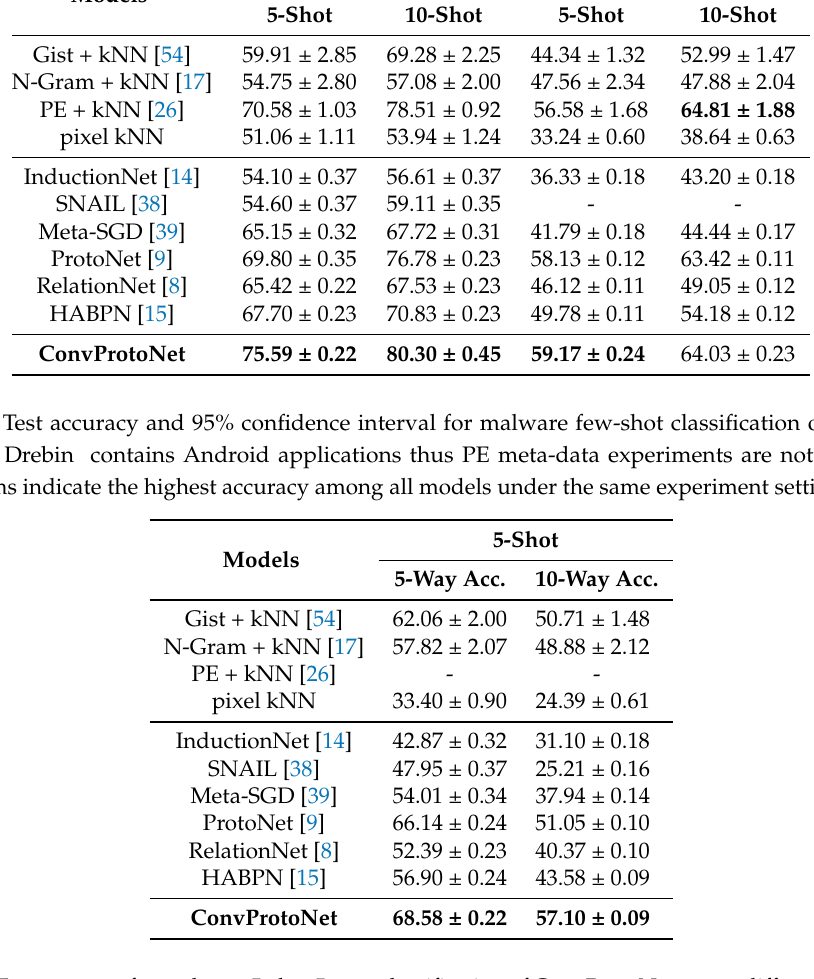
Table 4. Test accuracy for malware 5-shot 5-way classification of ConvProtoNet across different datasets and 95% confidence interval is attached after accuracy. Base dataset refers to the dataset that model trains on and tested dataset refers to the dataset that uses as meta-testing set and the native accuracy of each datatset is in